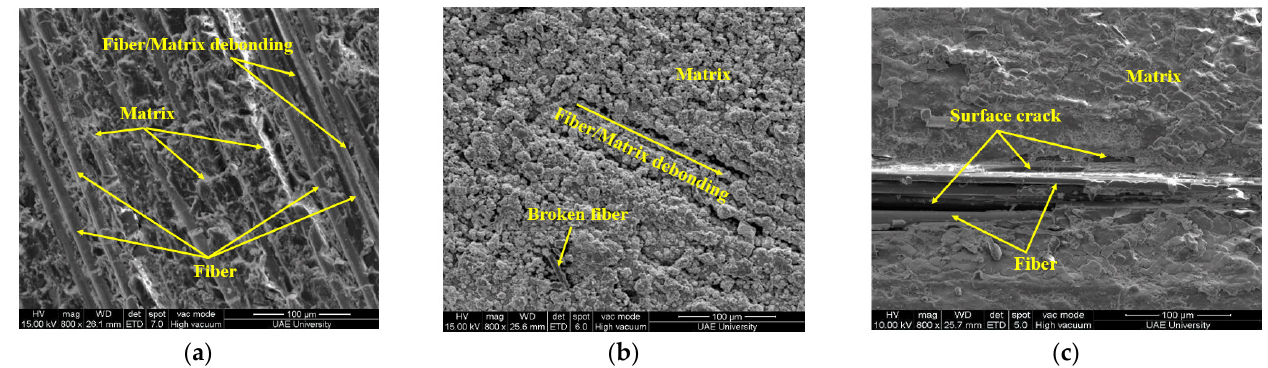
Figure 7. Stress–strain behavior of specimen immersed in seawater for ( a ) 3 months, ( b ) 6 months, ( c ) 9 months and ( d ) 12 months.